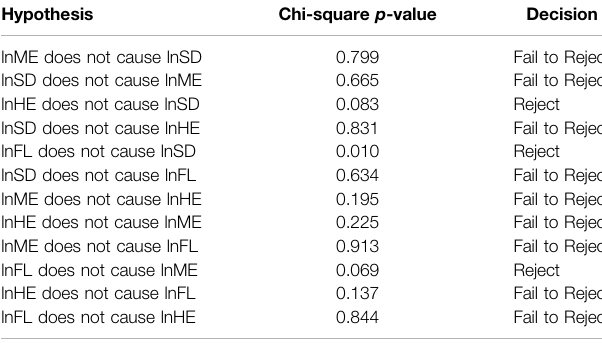
TABLE 8 | Estimation of Long Run Coef fi cients by FMOLS approach. Model: lnSD = f (lnME, lnHE, lnFL)